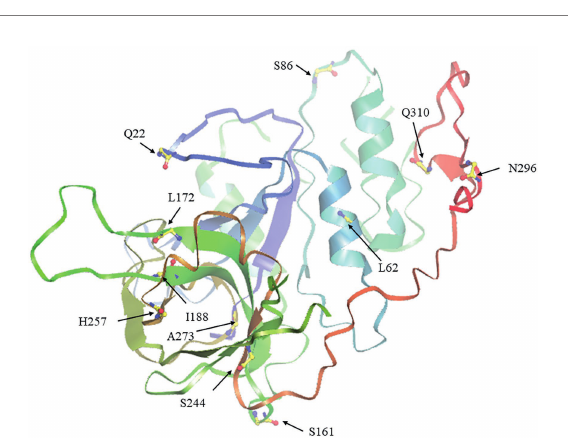
FIGURE 7 The tertiary spatial structure of BnSHI/STY protein in Clade 3. The eleven predicted positive selection sites were marked with